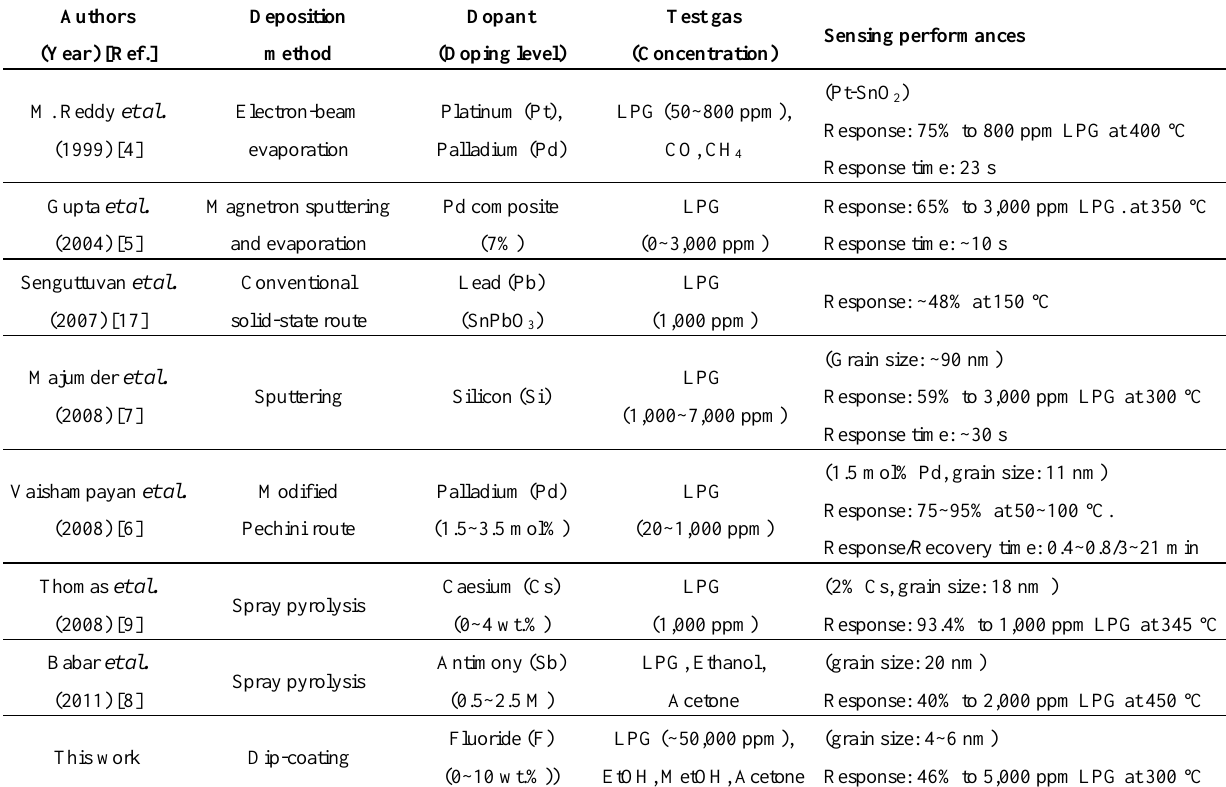
sensors for LPG 2